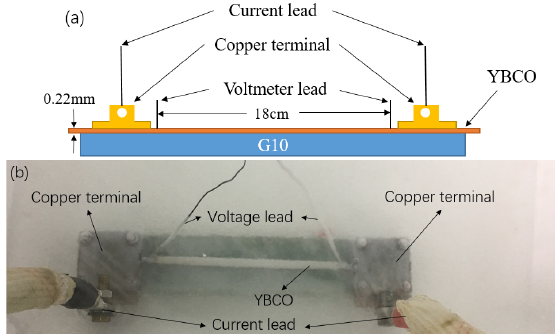
Figure 1. The experimental set-up, ( a ) schematic diagram, ( b ) Photo under test.